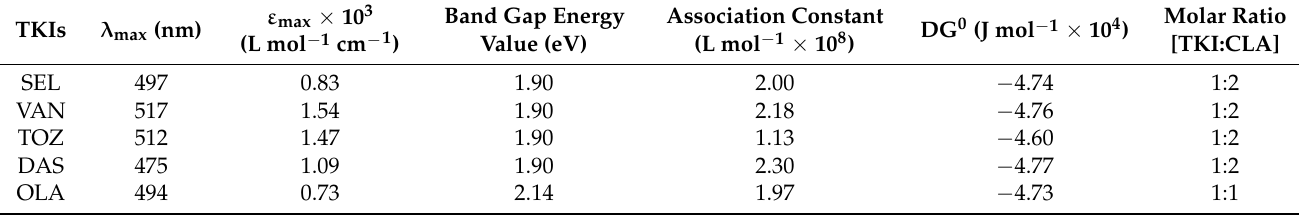
Table 2. Spectrophotometric parameters of the CT complex reaction of CLA with